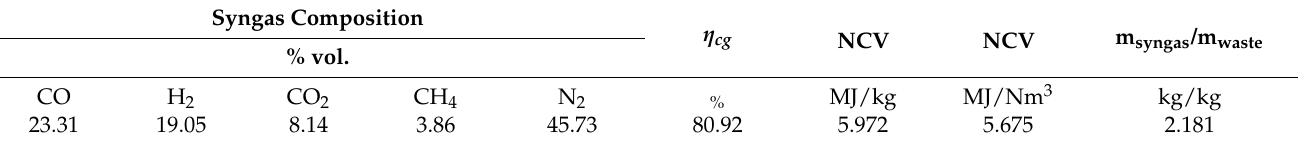
Table 6. Gasifier modeling results.